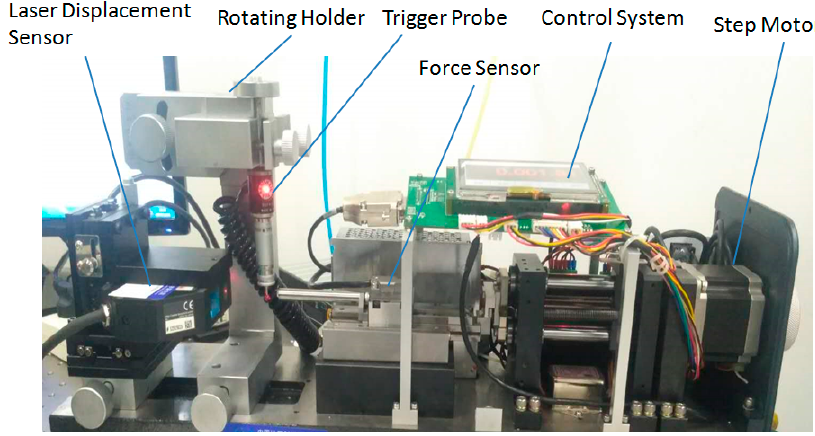
Figure 7. A picture of the probe parameter calibration system.